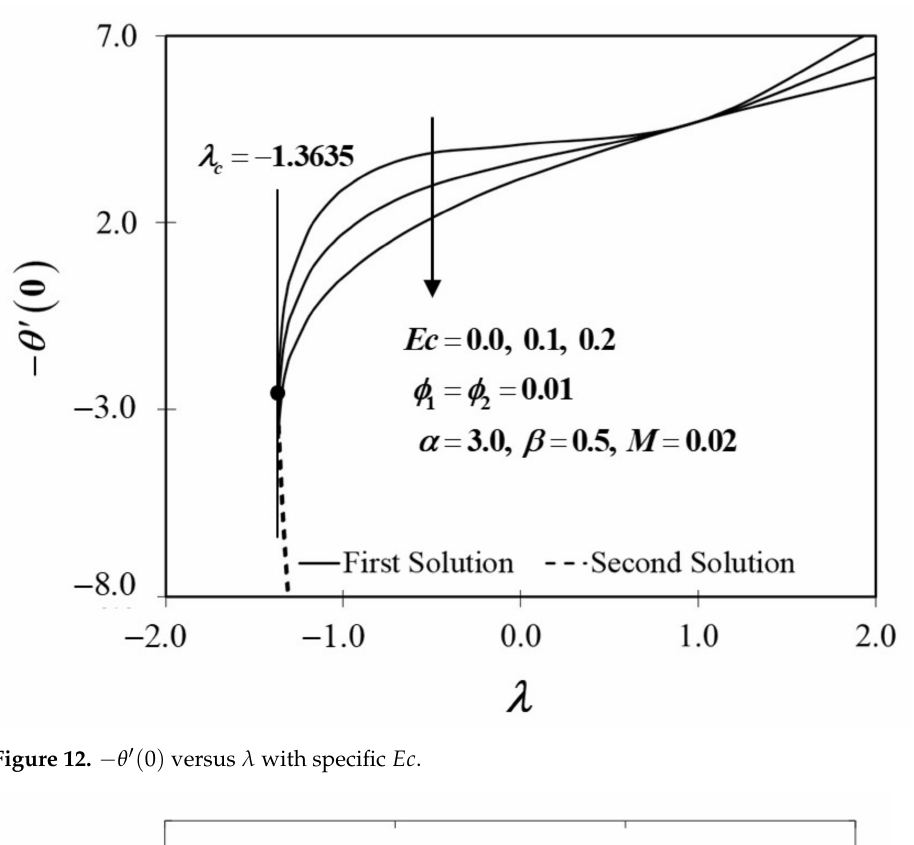
Figure 12. − θ (cid:48) ( 0 ) versus λ with specific Ec .